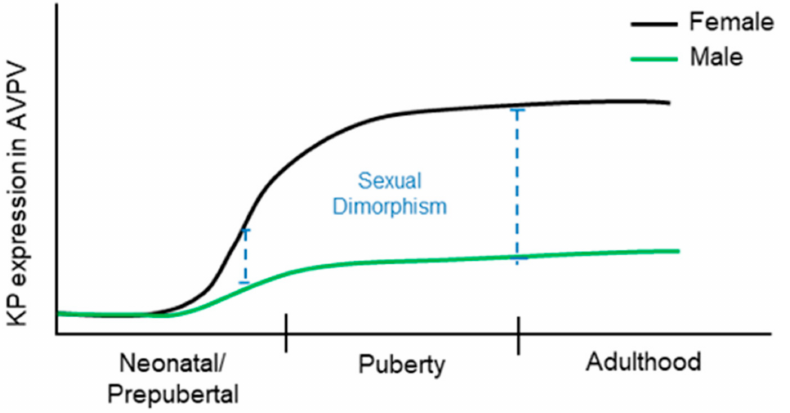
Figure 5. Kisspeptin expression in anteroventral periventricular and preoptic nuclei. The changes in kisspeptin (KP) expression in females (black line) and males (green line) were traced through the neonatal/prepubertal periods, the pubertal period, and the adulthood in previous studies. Until the second postnatal week, the expression of KP in the anteroventral periventricular and periventricular preoptic nucleus (AVPV/PeN) was not detectable. After KP expression becomes detectable in this region, a distinct sexual dimorphism persists throughout the postnatal life.